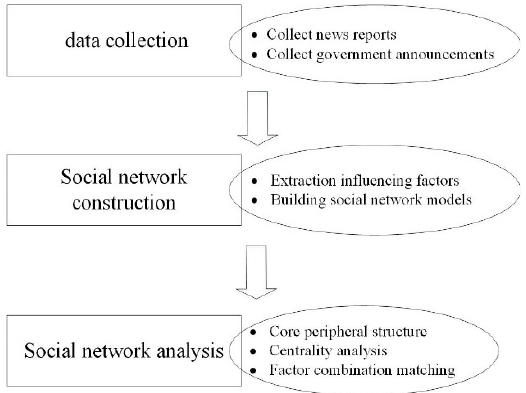
Figure 1. The research flow chart.